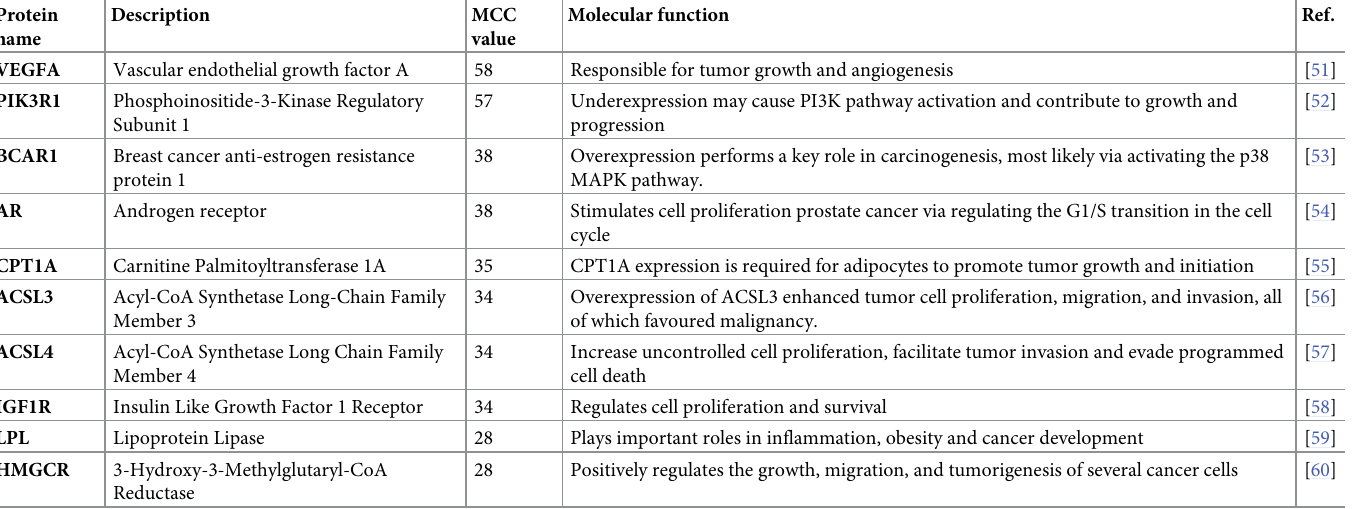
Table 3. Molecular functions of the ten hub proteins associated with the four risk